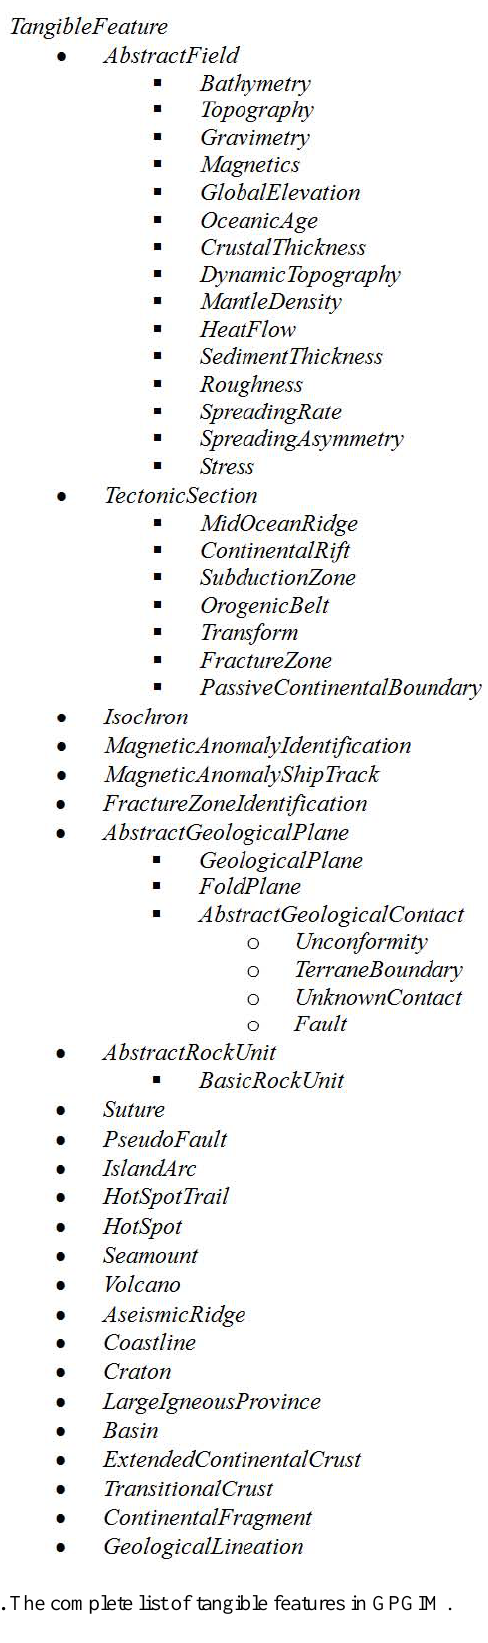
Fig. 4. The complete list of tangible features in